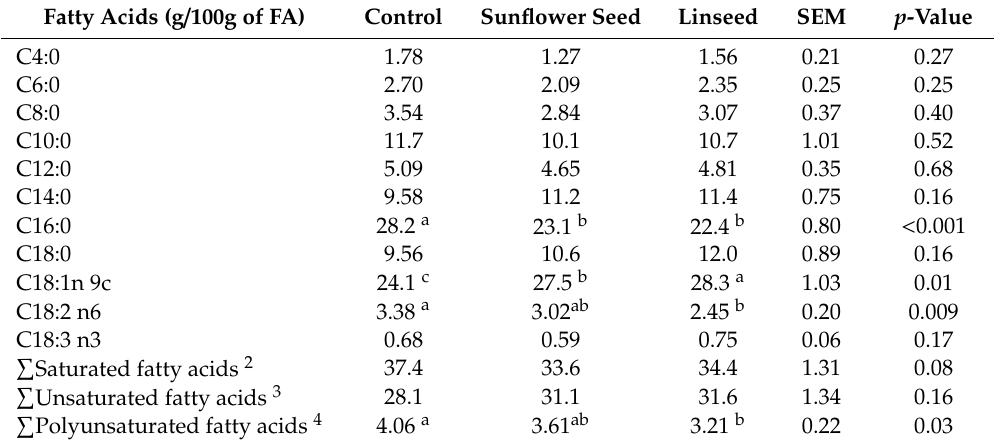
Table 6. Milk fatty acid profile from goats fed control (Megalac-R ® ), sunflower (SF) and linseed (LS) treatments (n = 9 per treatment) 1